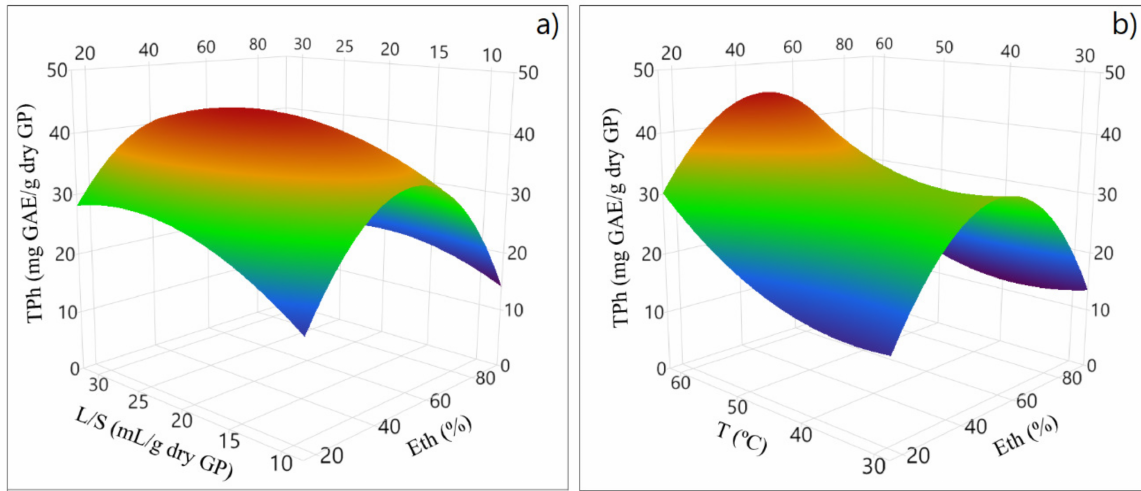
Figure 3. Response surface plots for the effect of ( a ) liquid–solid ratio (L/S) and ethanol concentration (Eth); and of ( b ) temperature (T) and ethanol concentration (Eth) on total phenolic content